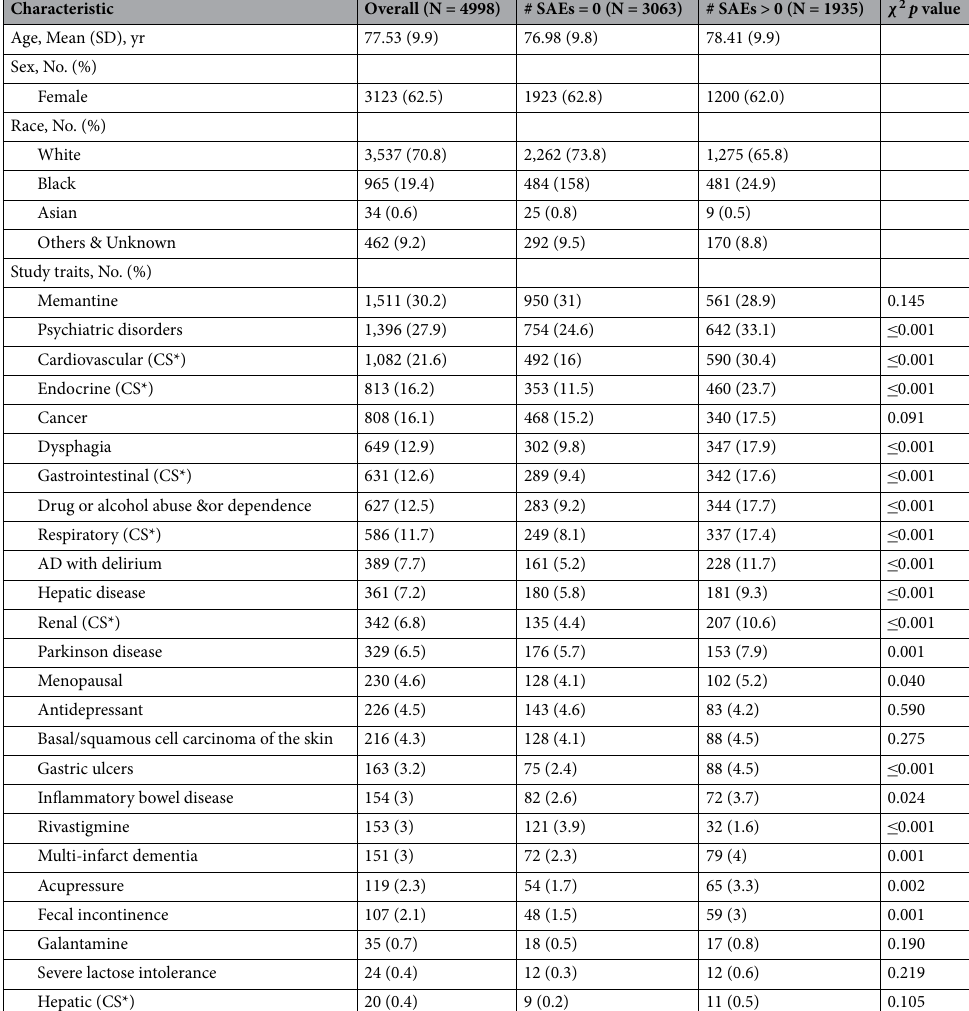
Table 1. Demographic characteristics and selected traits of the target population of the donepezil clinical trial for AD. CS * Clinically significant. If the disease causes hospitalization, we consider it as “clinically significant”.